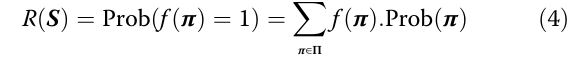
Fig. 1 Exponential reliability function plot for different values of MTTF (1000, 2000, 3000, and 4000) in